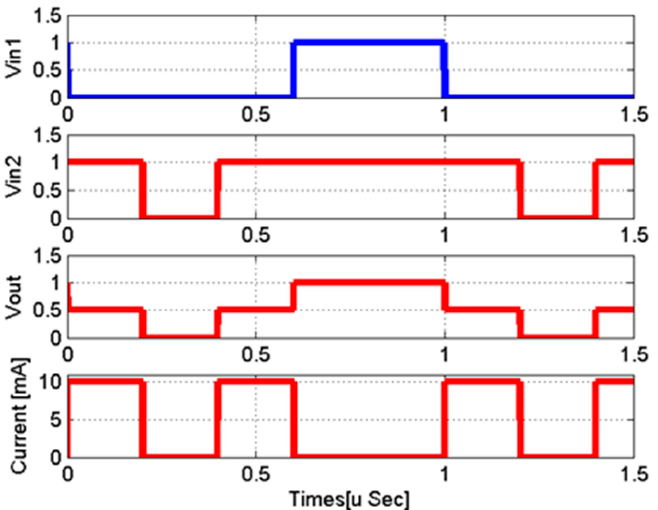
Figure 7. Simulation of the proposed DAC cell with the following sequence of inputs for ( V in 1 , V in 2 ): (0,0), (0,1), (1,1), (0,1), and (0,0).